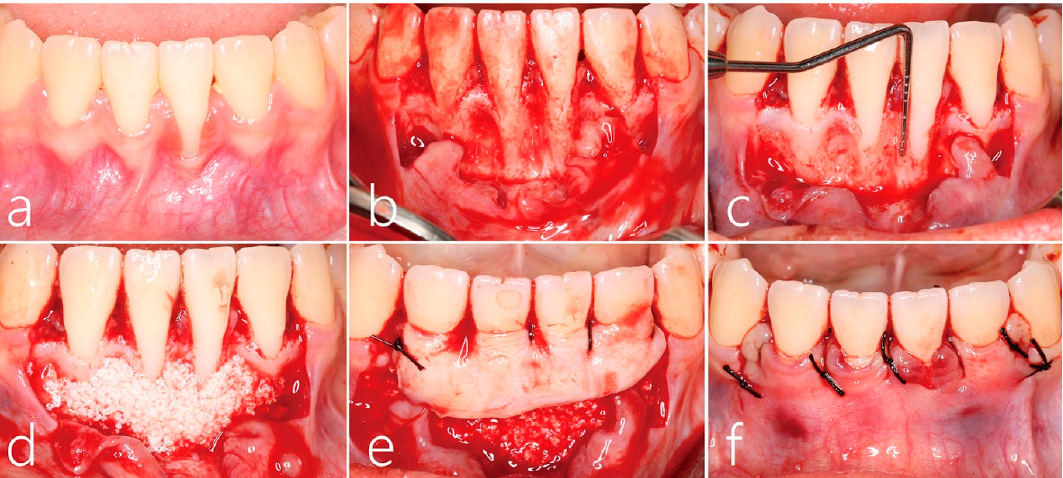
extended to the mucogingival junction. ( b ) After reflection of a full-thickness flap on the labial side, root planing was performed. ( c ) The labial dehiscence of the left lower central incisor was >7 mm from the cemento-enamel junction, and interproximal concavity was observed. ( d ) The interproximal concavity and thin labial bony plate were filled with a synthetic bone graft substitute. ( e ) The subepithelial connective tissue graft obtained from the left palate using the trap-door approach was fixed with a 5-0 catgut suture slightly above the cemento-enamel junction. ( f ) The overlying flap was closed with 5-0 black silk to ensure the subepithelial connective tissue graft was